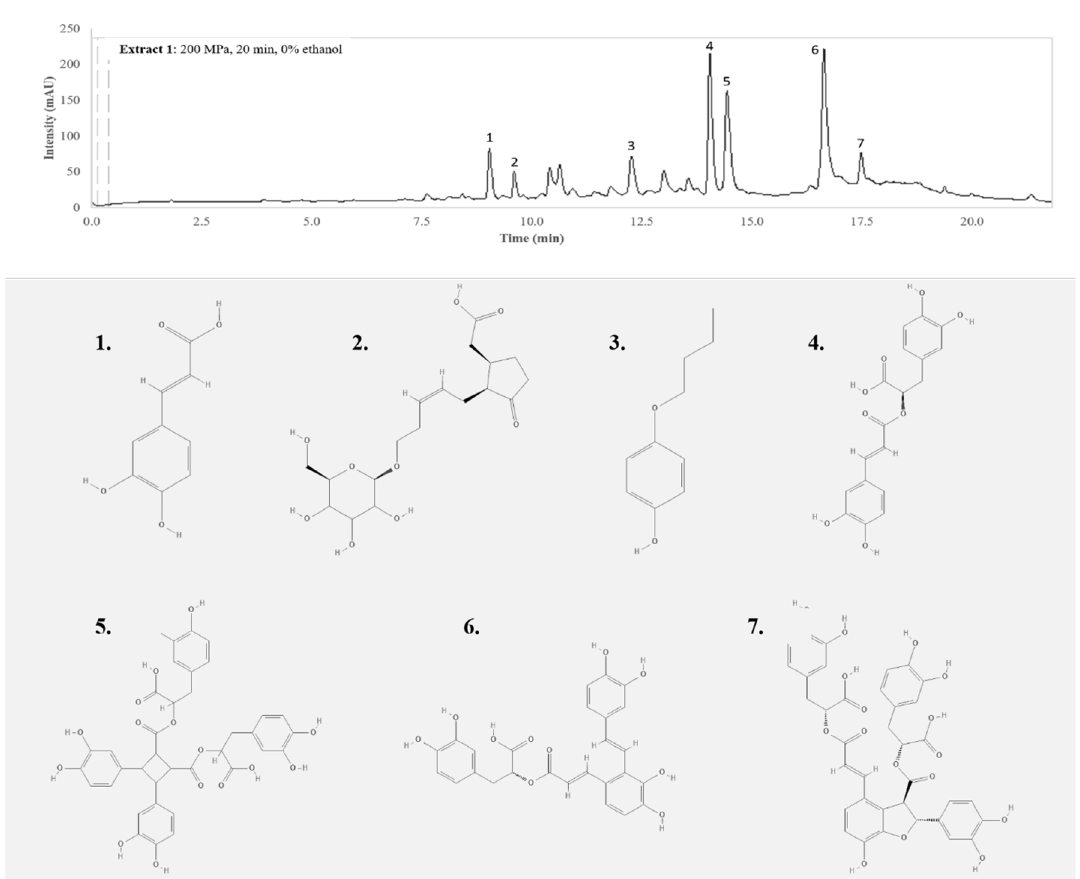
Figure 1. LC-MS/MS chromatogram was acquired at 320 nm of the analyses of extract 1 (S500/20/0) from winter savory leaves. The numbers 1 to 7 indicate the seven phenolic compounds identified in this extract: 1, caffeic acid; 2, tuberonic acid glucoside; 3, 4-butoxyphenol; 4, rosmarinic acid; 5, sagerinic acid; 6, salvianolic acid A; and 7, salvianolic acid B isomer.